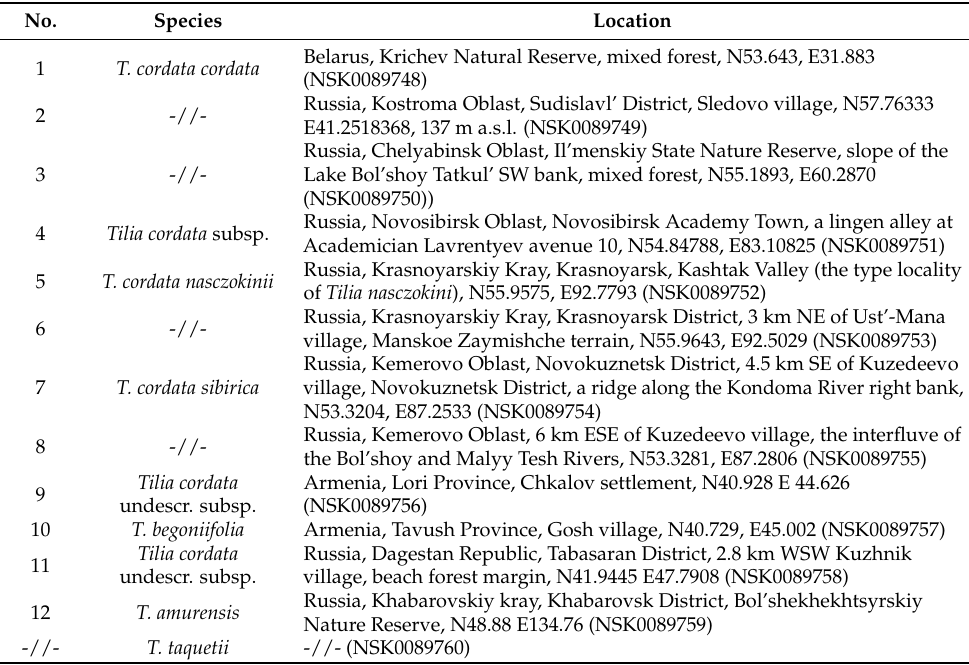
Figure 1. Sampling locations of the studied Tilia specimens. Location numbers in circles refer to Table 1. Distributions of T. sibirica and T. nasczokinii are too small so they are only represented by location circles (locations 5,6 and 7,8, respectively). Distribution of T. cordata is shaded in green; distribution of T. taquetii and T. amurensis is shaded in red. Arrows indicate putative dispersal routes of T. cordata after the LGM. Table 1. Studied specimens. Numbers refer to Figure 1. Voucher numbers are given in parentheses.